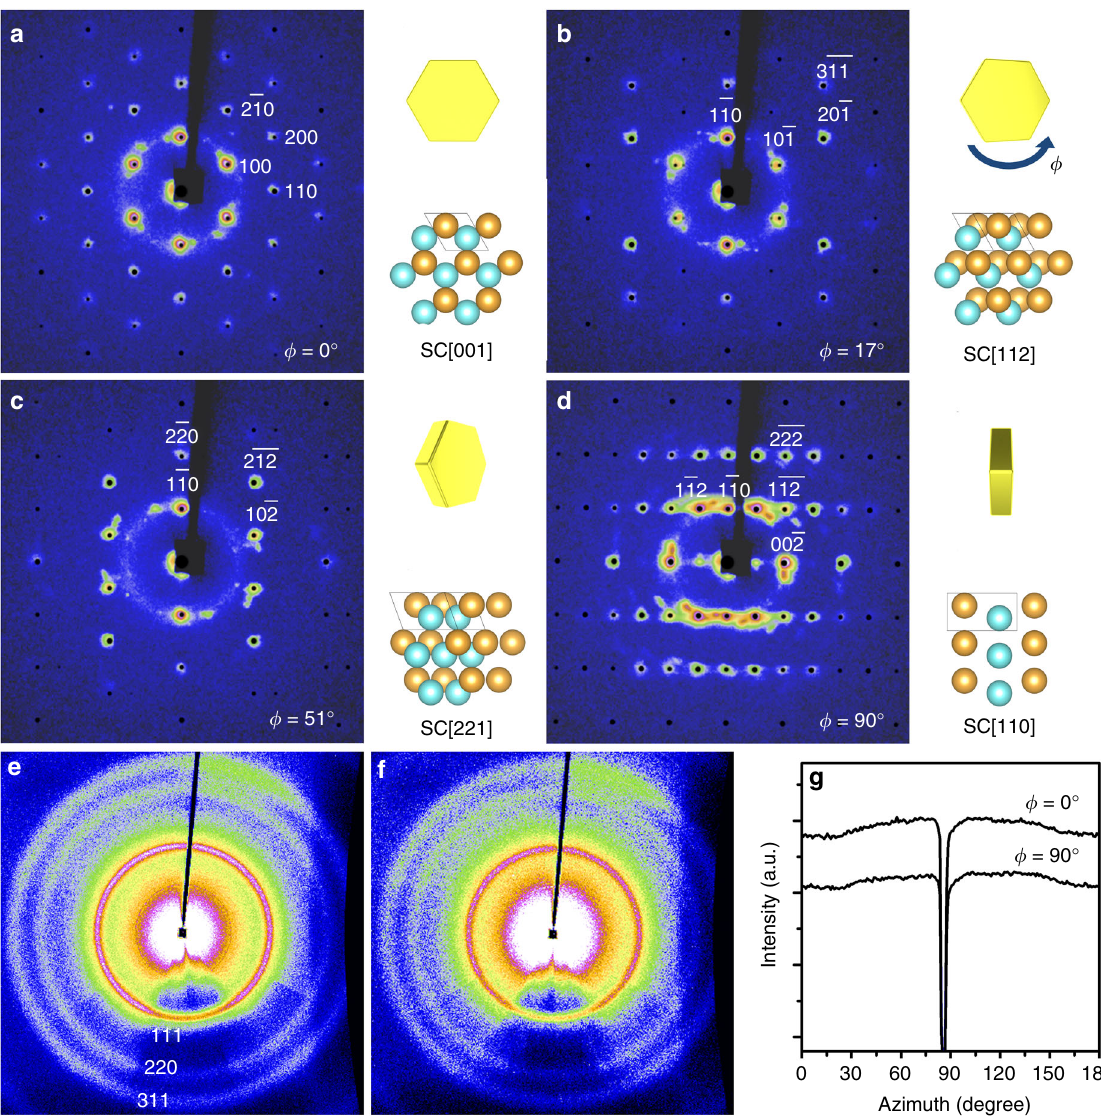
Fig. 2 Supercrystallography analysis of a single gold SC at varying rotational angle phi ( ϕ ). a – d SAXS patterns in selected projections. Simulated peaks (black dots) from an hcp superlattice are overlaid on top of experimental patterns with Miller indices labeled. Insets of a – d present corresponding schematic illustrations of a rotating SC with X-ray beam shooting perpendicular to paper and an hcp superlattice in the same projections as labeled by SC [hkl]. Three consecutive hexagonal monolayers are shown in two different colors to emphasize the ABA packing for visual aid. WAXS patterns from the same SC with e ϕ = 0° and f ϕ = 90°, collected simultaneously with the SAXS patterns in a , d , respectively. Powder scattering rings from gold atomic lattice are marked with Miller indices. g Integrated azimuthal WAXS spectra of the Au (111) peak. The sharp dips were caused by beam-stop